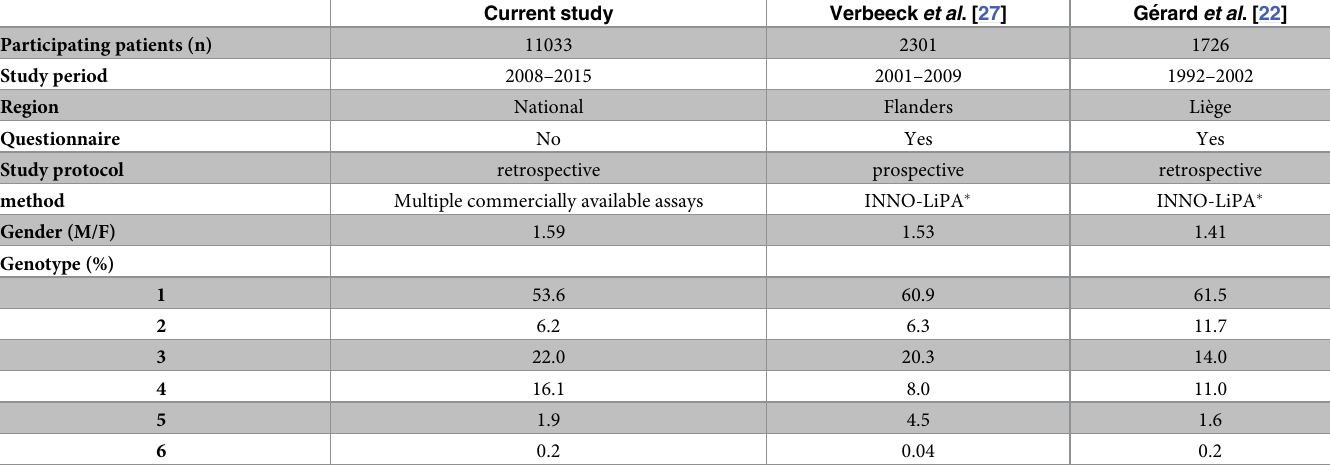
Table 2. Comparison of genotype distribution and the main study characteristics between the current study and previously published studies describing the HCV genotyping in the Belgian general